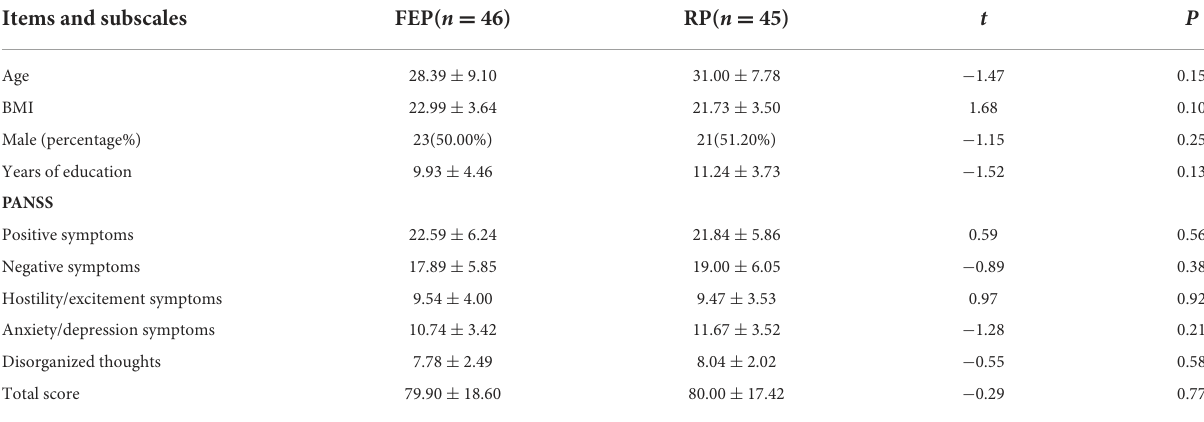
TABLE 1 Demographic information and psychotic symptom, suicidal symptom of participants. Items and subscales